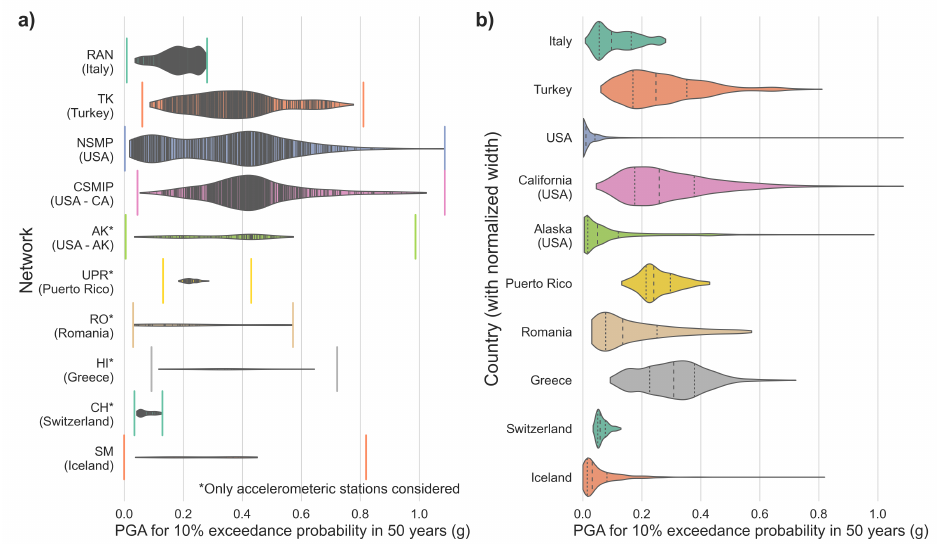
Figure 8. ( a ) Distribution of the accelerometric stations from different strong-motion networks with respect to the seismic hazard values (PGA for 10% exceedance probability in 50 years); ( b ) width- normalised distribution of the seismic hazard values (PGA for 10% exceedance probability in 50 years) in different